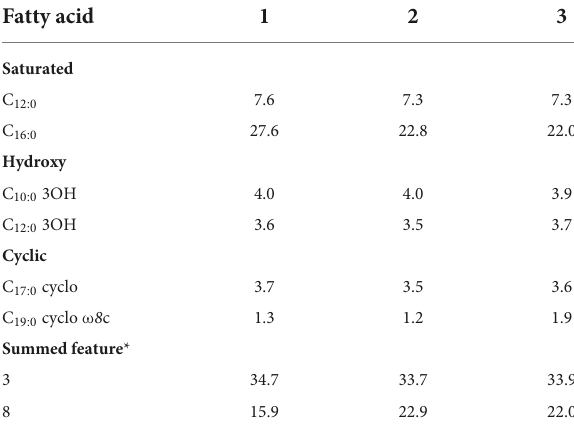
TABLE 2 Cellular fatty acid compositions of strain MAP12 T and related